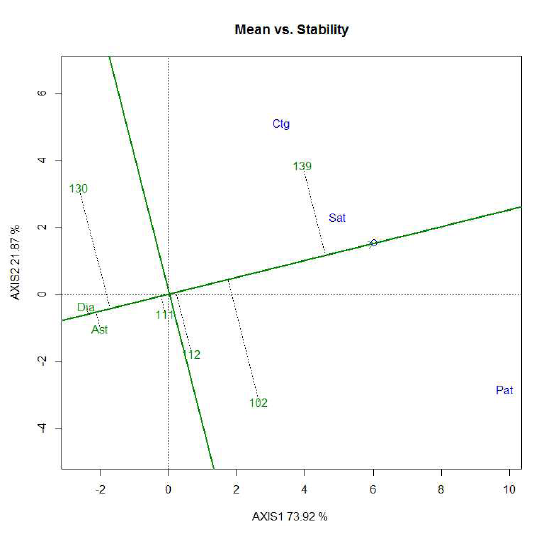
Figure 6: Polygon view of GE interaction for CIP potato clones over 3 locations during 2013-14 (Ctg=Chittagong, Pat=Patuakhali and Sat= Satkhira)